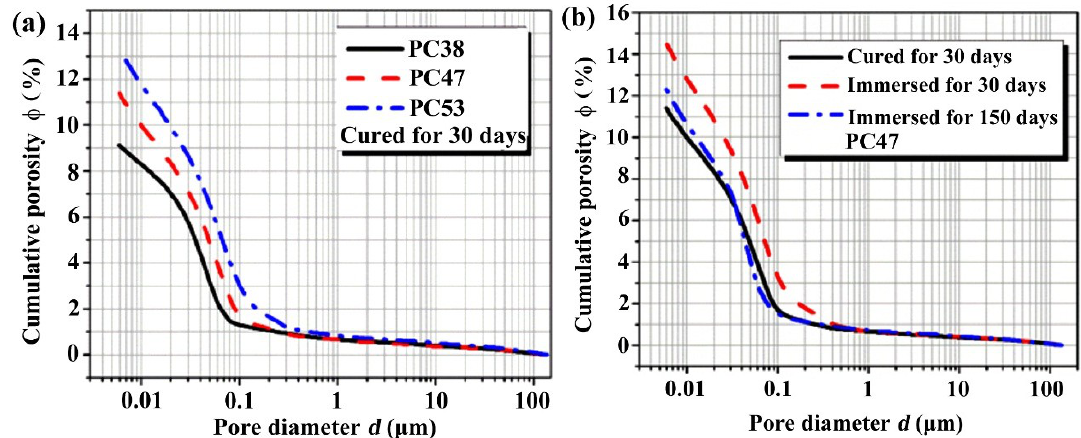
Figure 3. Pore structures of plain cement concretes characterized by MIP: ( a ) influence of w/c, after cured for 30 days; ( b ) influence of